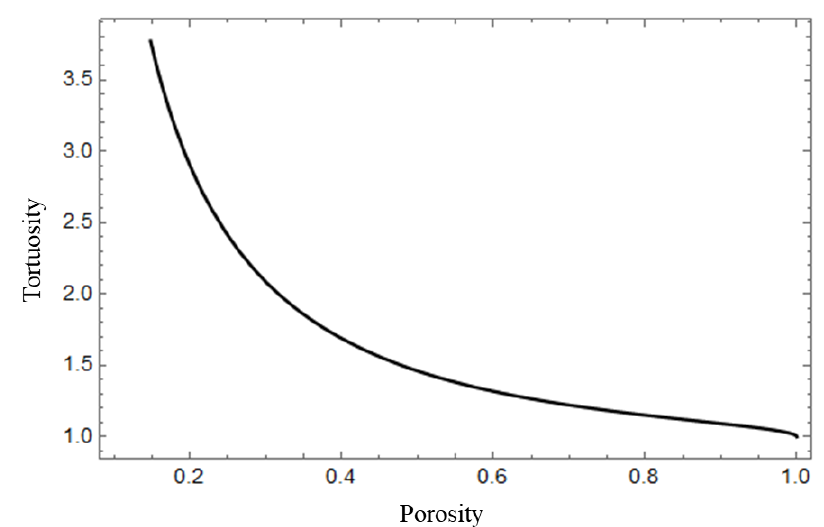
Figure 6. The variation of the tortuosity with the